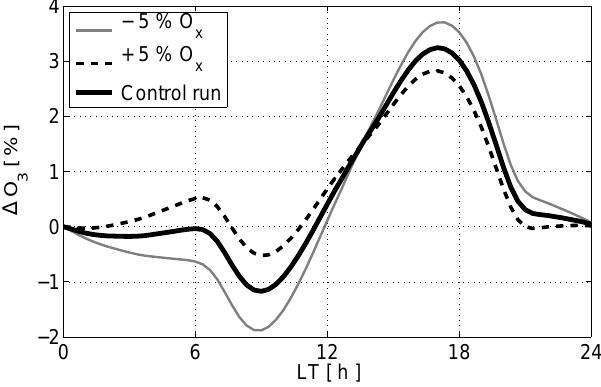
Figure 11. Zonal-mean conversion rates of ozone derived from a simulation with 5% more initial O x concentration and a control simulation on 1 January, 5hPa, 22 ◦ N.